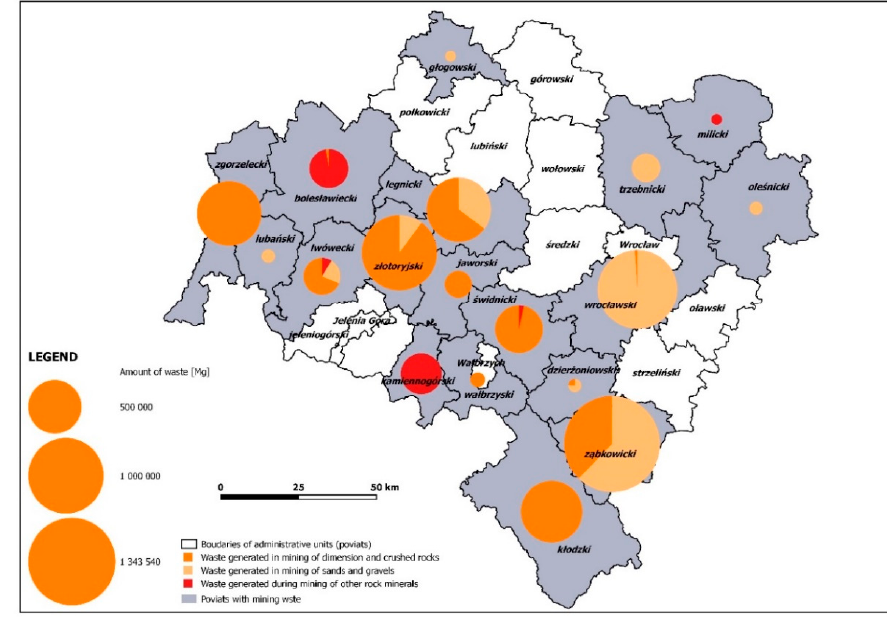
Figure 5. Mining waste generated in the mining and processing of the three main groups of rock minerals in Lower Silesia: dimension and crushed rocks, sands and gravels and other rock minerals [Mg].